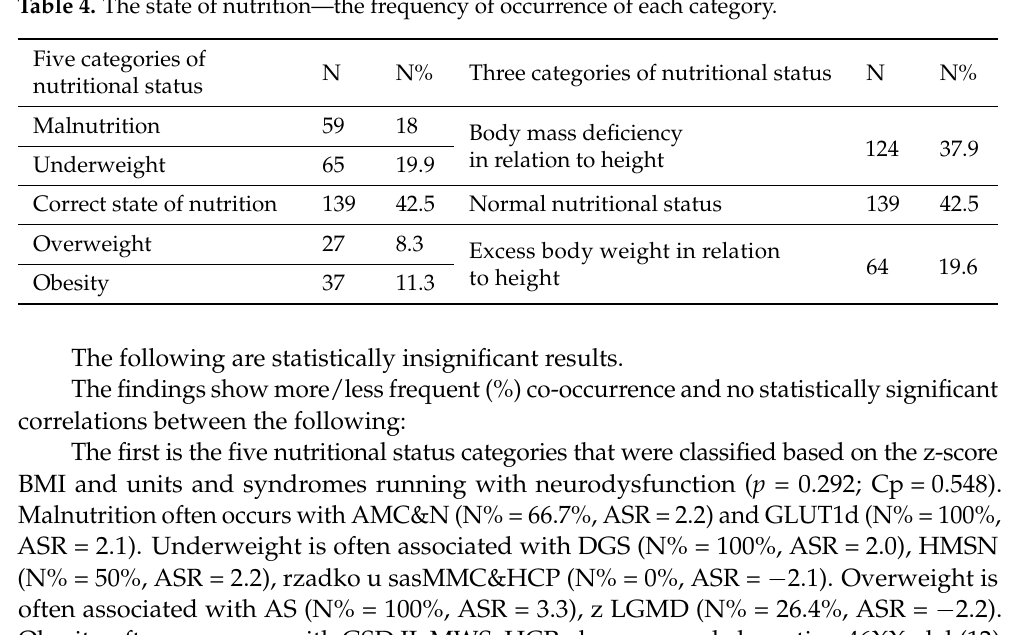
Table 4. The state of nutrition—the frequency of occurrence of each category.